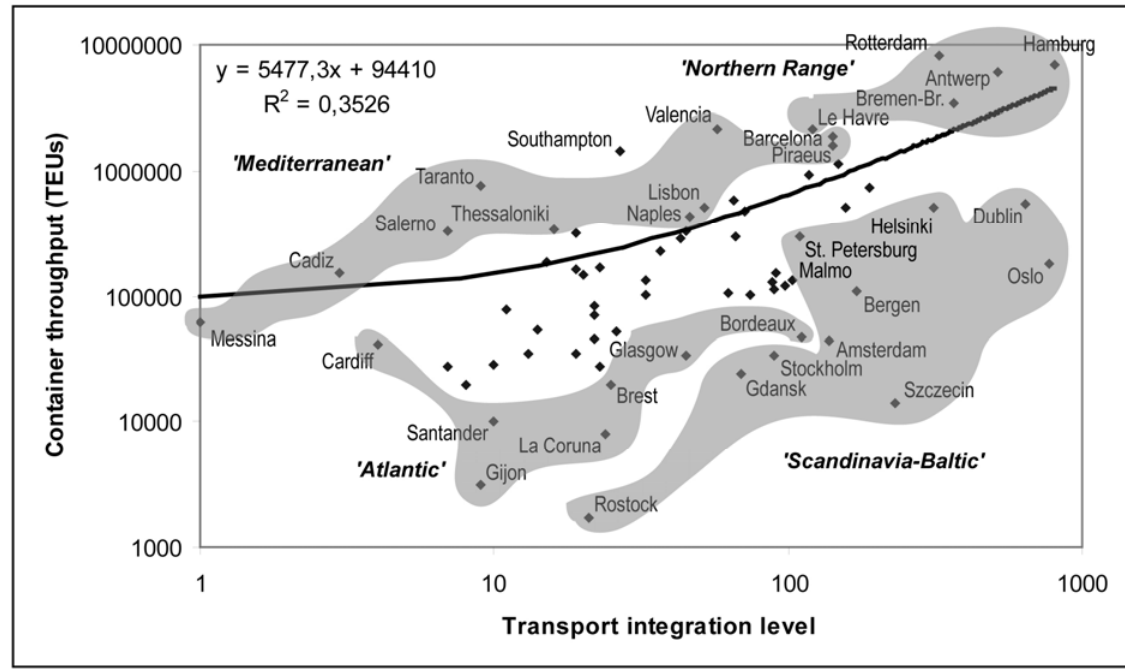
Figure 6. Transport integration and port performance,